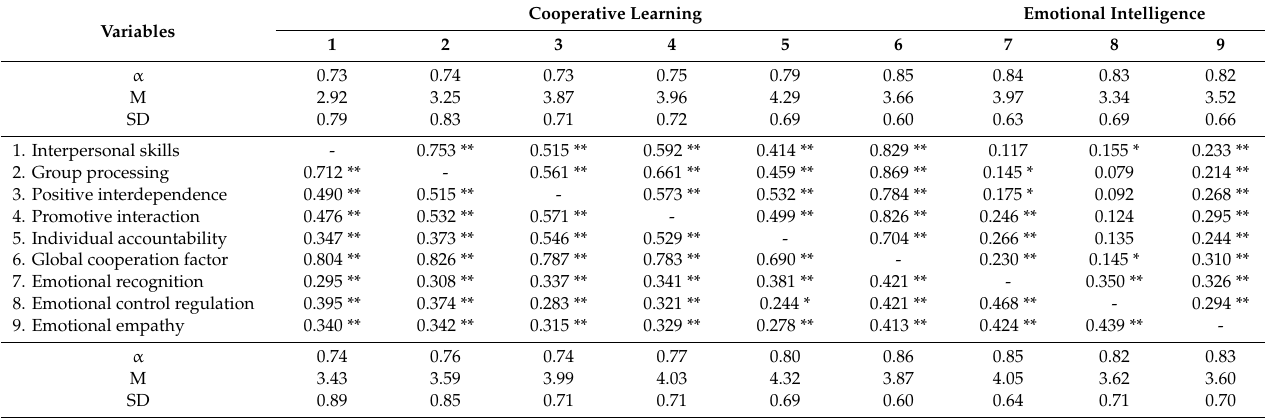
Table 2. Alphas, means, standard deviations and bivariate correlations of the observed variables in students across all school stages (below) and those undertaking baccalaureate study